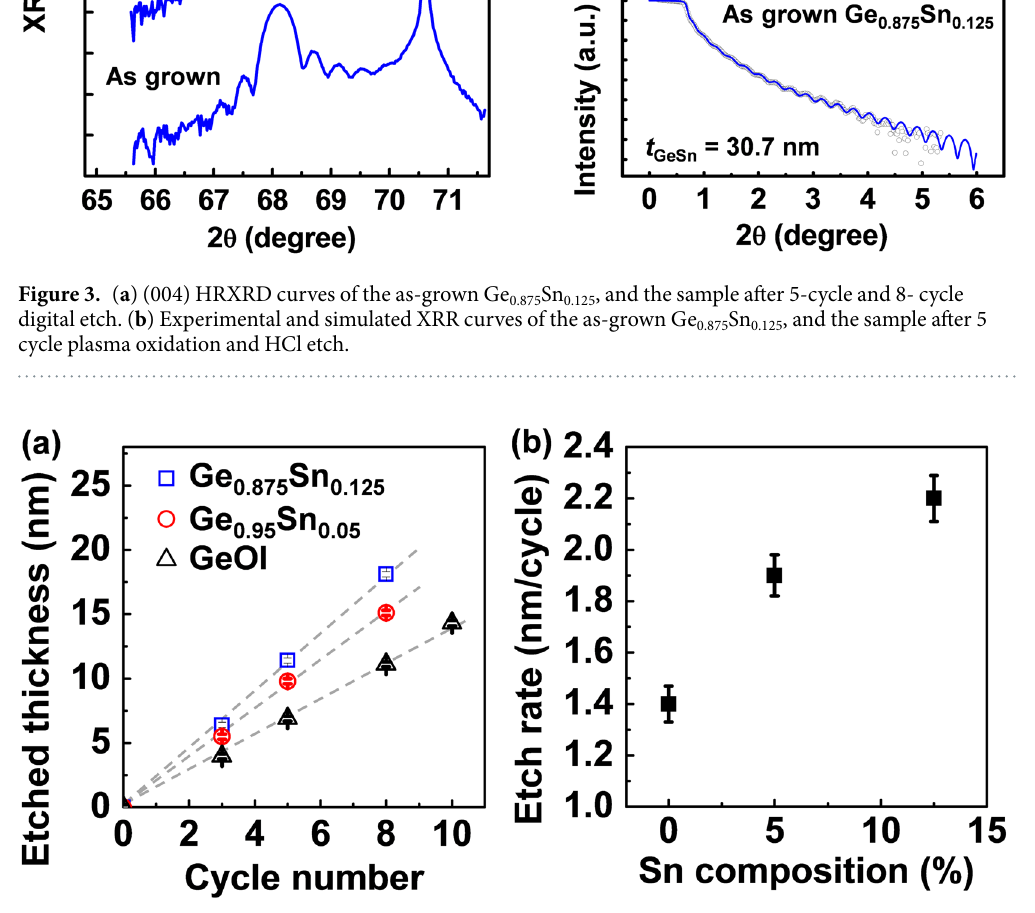
Figure 5d and e show the AFM images of the commercial GeOI wafer and the wafer after 10-cycle digital etch. It